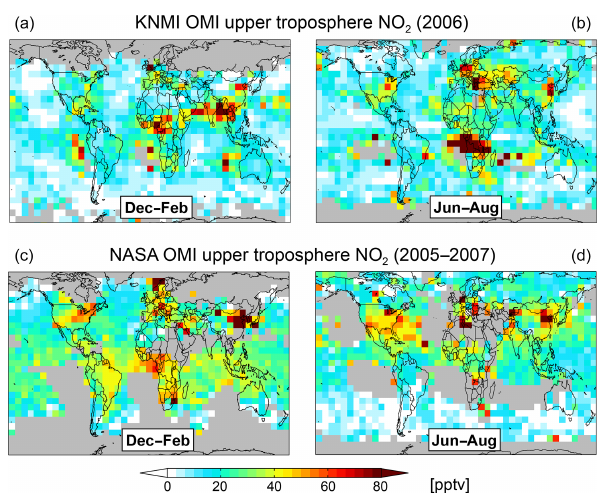
Figure 1. Upper troposphere (UT) NO 2 from the OMI satel- lite instrument. Seasonal mean UT NO 2 from KNMI in 2006 at 330–450hPa (a, b) is compared to NASA in 2005–2007 at 280–450hPa (c, d) . Data are at 5 ◦ × 8 ◦ horizontal resolution for December–February (a, c) and June–August (b, d) . Grey areas in- dicate no data and, for NASA, scenes with fewer than 50 measure-